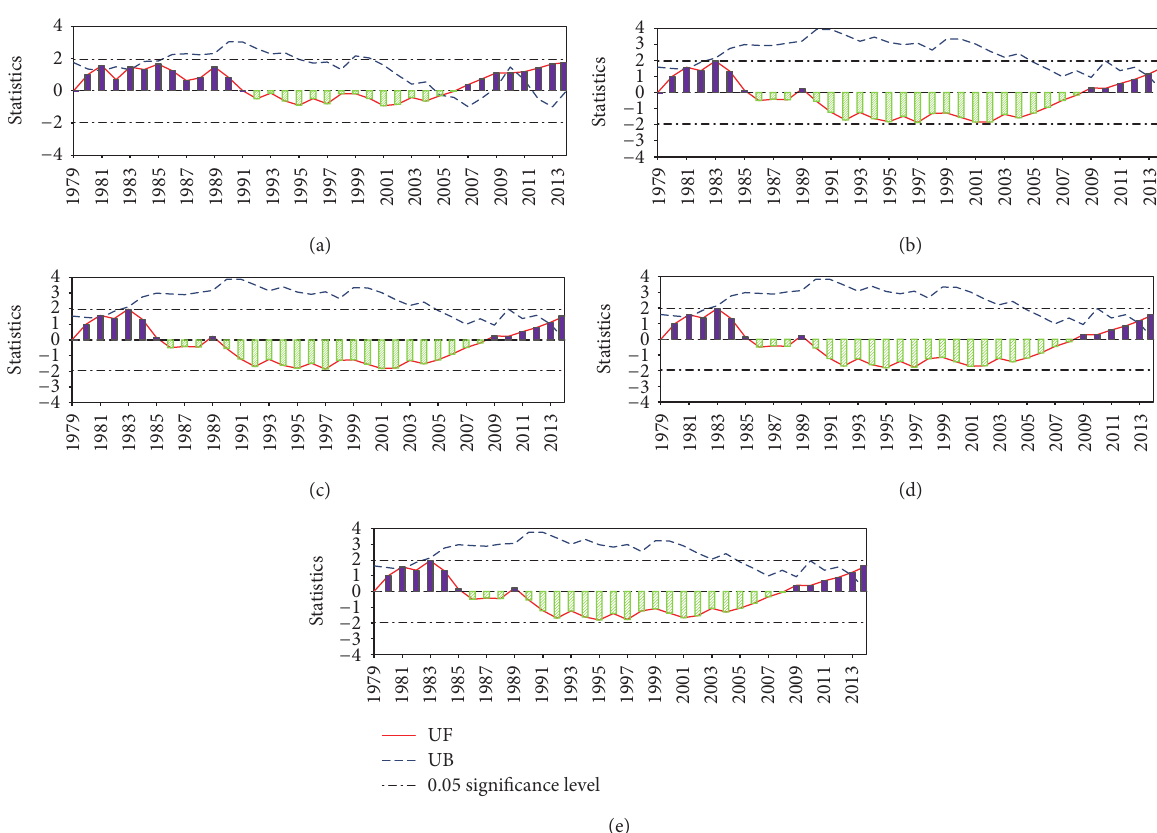
rates of increase at the Yingluoxia, the Caotanzhuang hydro- junction, the S213 Bridge, the G312 Bridge, and the Tielu Bridge are 0.0695 × 10 8 m 3 /a, 0.0603 × 10 8 m 3 /a, 0.0549 × 10 8 m 3 /a, 0.0465 × 10 8 m 3 /a, and 0.0436 × 10 8 m 3 /a,